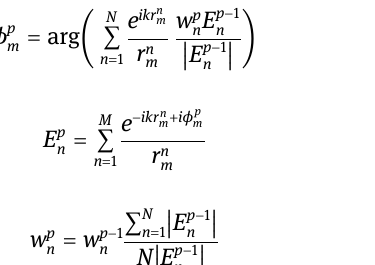
(4), the weight factor w m is adjusted step by step until the least mean square error between the target and the recon- structed image becomes less than a predesigned threshold.